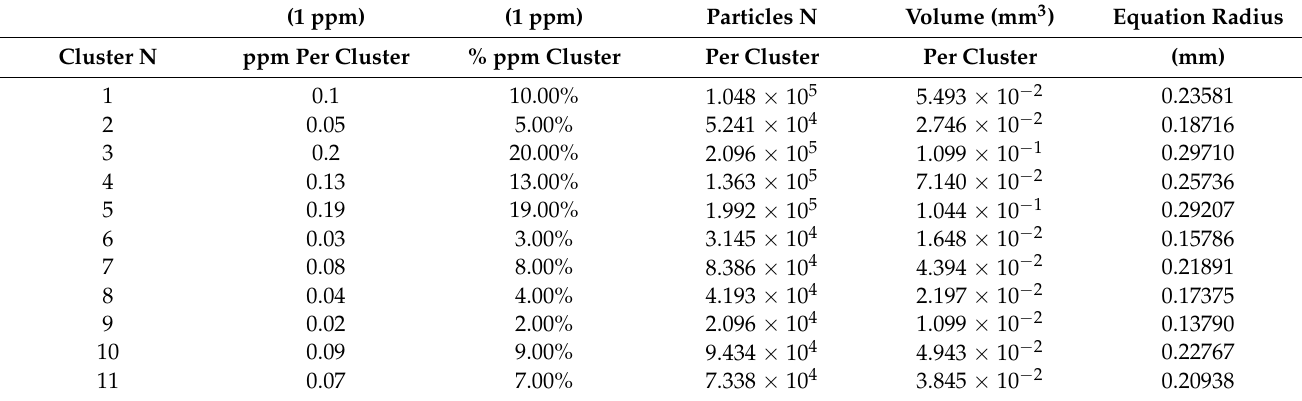
Table 5. Cluster configuration—1 ppm PO4